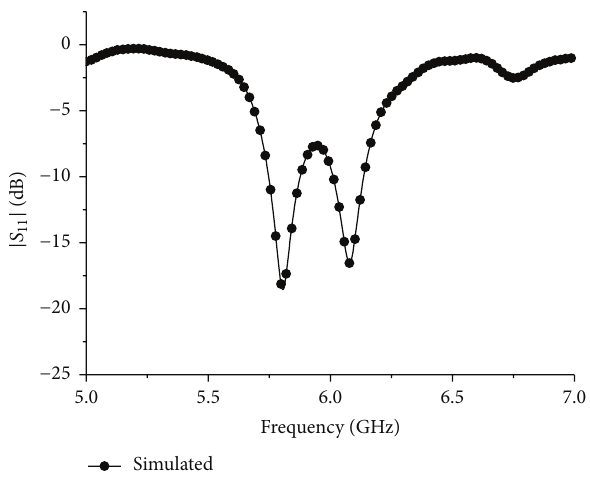
Figure 3: Simulated |𝑆 11 | for the microstrip reflectarray designed by the conventional